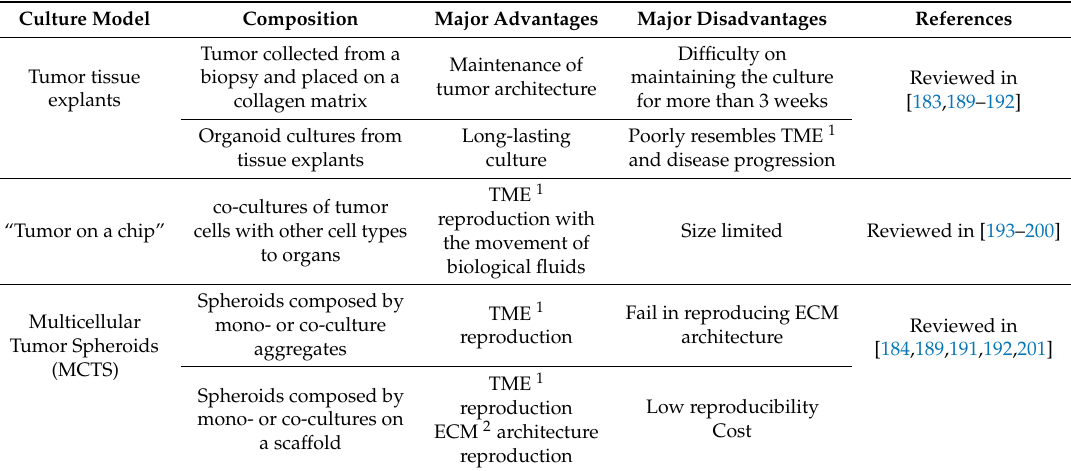
Table 6. Summary of currently available 3D culture models of cancer.